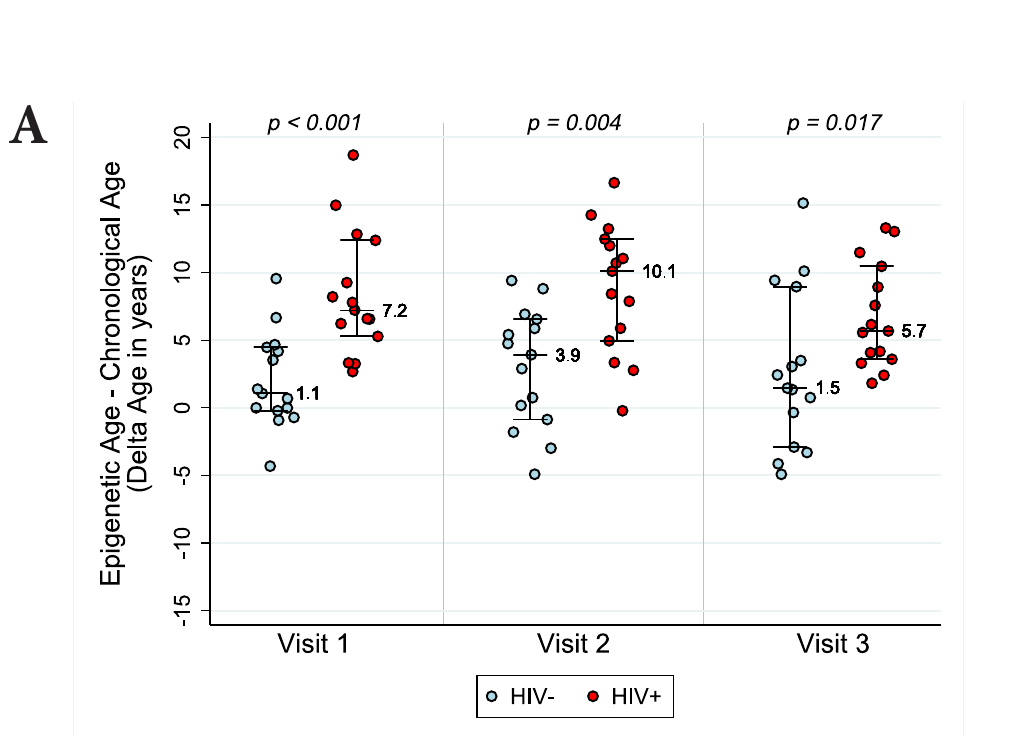
Figure 1A. Epigenetic age acceleration for HIV- and HIV+ before and after initiation of ART. Box plots of Methylation Age minus Chronological Age (Figure A), age acceleration residual (Figure B), and Extrinsic age acceleration (Figure C), in years of two groups, HIV- and HIV+ individuals (n=15 per group). Reported p values are a result of Wilcoxon rank sum tests between the two serostatus groups at the 3